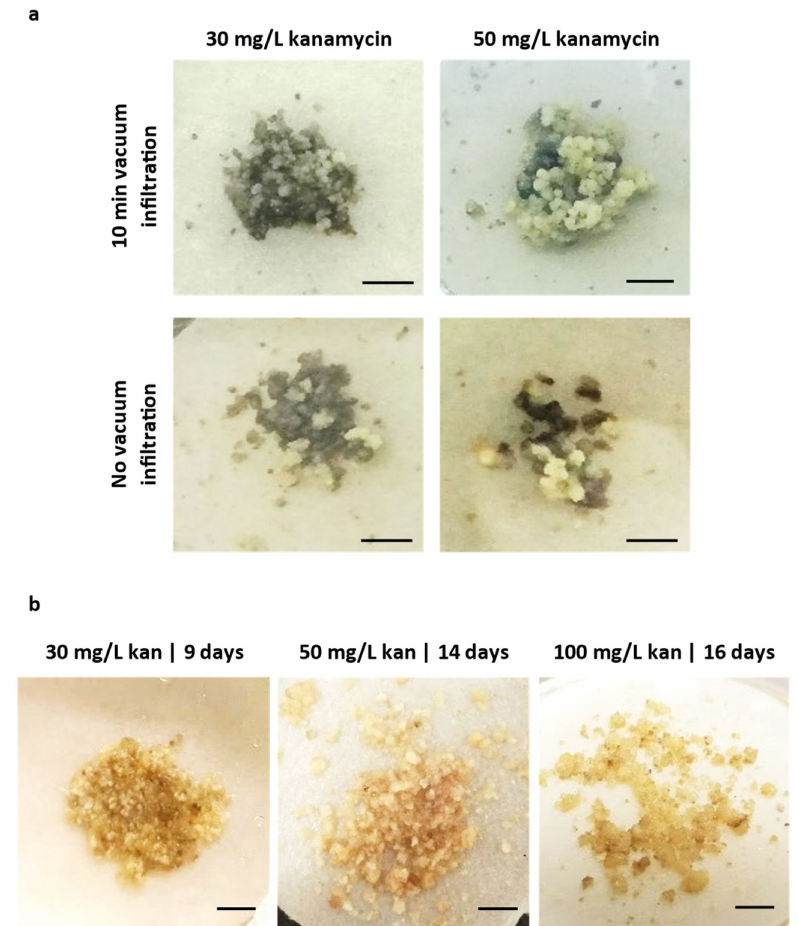
Figure 3. Tamarillo embryogenic callus inoculated with EHA105 Agrobacterium strain and incubated with increasing kanamycin concentrations. ( a ) Images represent inoculation with and without a 10 min vacuum, followed by incubation at 80 rpm and 28 ◦ C for another 10 min. ( b ) Incubation in the selective medium with kanamycin at 30 mg/L for 9 days, 50 mg/L for 14 days and 100 mg/L for 16 days. Bars represent 0.5